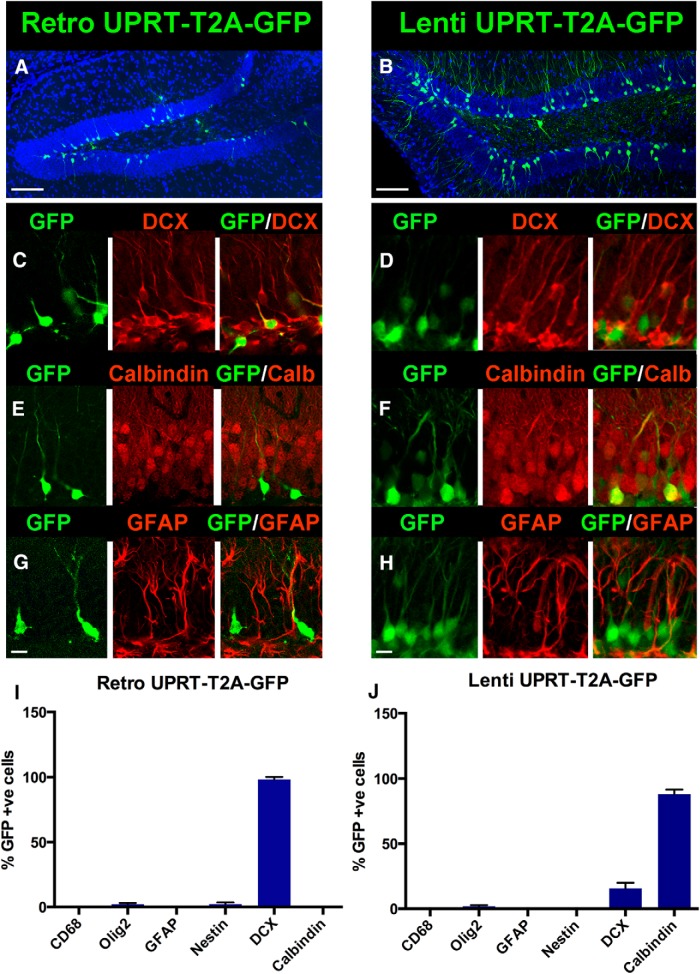
Validation of cell specificity of UPRT-expressing retroviral and lentiviral constructs by immunocytochemistry at 14 DPI. A, B, GFP staining in hippocampal sections from mice injected with UPRT-T2A-GFP retrovirus (A) and lentivirus (B) 14 DPI. Scale bar, 50 μm. C–H, Immunostaining for retrovirally and lentivirally labeled cells with the immature neuron marker DCX (C, D), mature neuronal marker calbindin (E, F), and the astrocytic marker GFAP (G, H). I, J, Retrovirus-expressing neurons were labeled with DCX, but not mature neuron or glial markers at 14 DPI (I), whereas lentivirus-expressing neurons were labeled with the mature cell marker calbindin as well as a small population of DCX (J). Scale bar, 10 μm. Data are plotted as the mean ± SD.